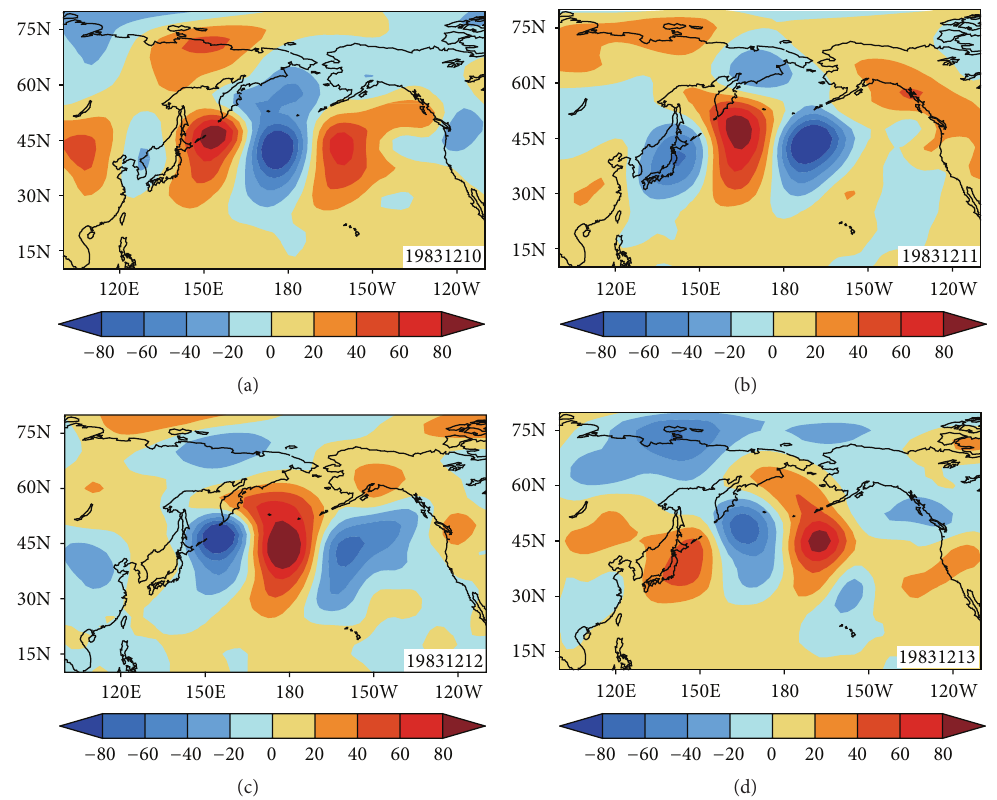
Figure 5: The synoptic-scale geopotential height perturbations at 850 hPa from 10 to 13 December 1983 (unit: gpm).